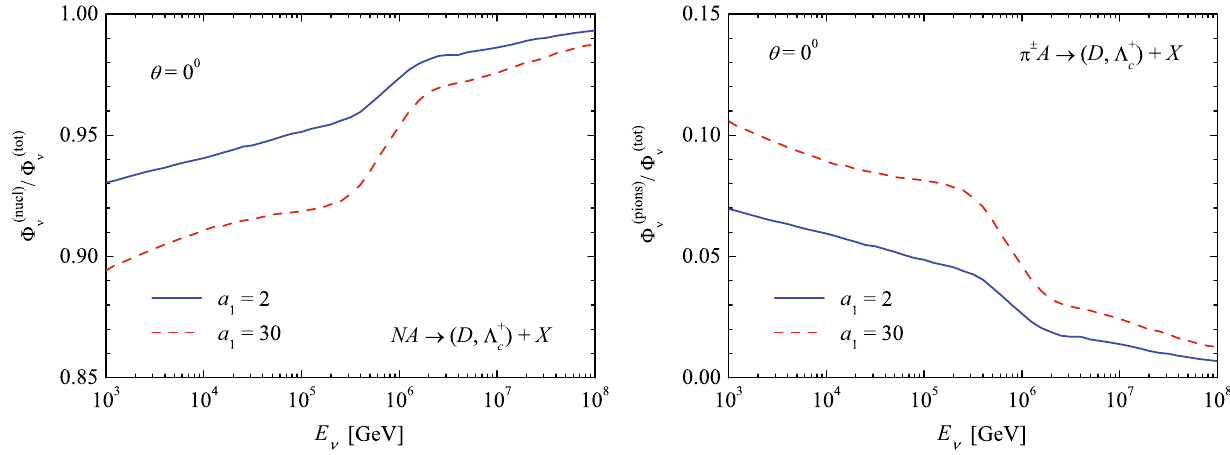
Fig. 13 Partial contributions of N A (left) and π A collisions (right) to the prompt muon neutrinos calculated for NSU spectrum with α ψ ( 0 ) = − 2 . 2 for a 1 = 2 (solid line) and a 1 = 30